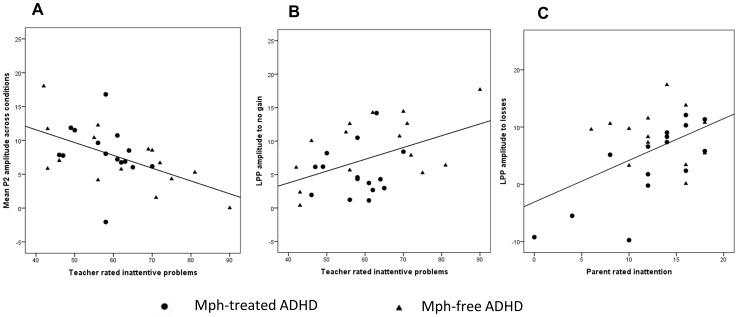
Scatterplots of associations between feedback-locked ERPs and severity of inattention problems.Scatterplots of associations between feedback-locked ERP amplitudes in microvolts and the ADHD inattention scales; A) negative association of teacher rated inattentive problems (CTRS-R) and feedback P2 in gain and loss condition (r = –.38 to –.56), B) positive association of teacher rated inattention (CTRS-R) and feedback LPP to no gain (r = .44), C) Positive association of parent rated inattention (DISC-IV) and feedback LPP to losses (r = .50). The correlations were computed across Mph-treated (circles) and Mph-free (triangles) children with ADHD.